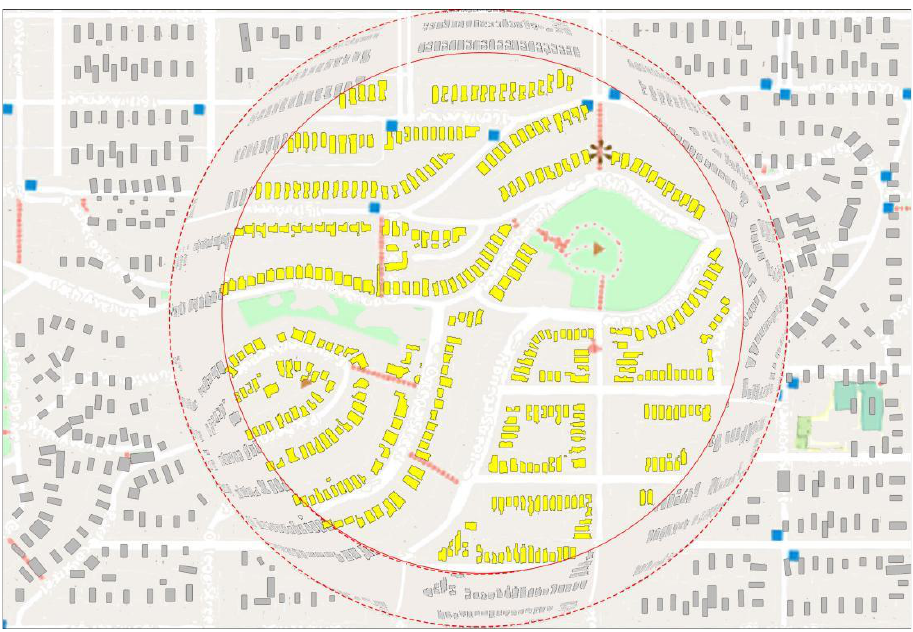
Figure 20. Overlay with original OSM